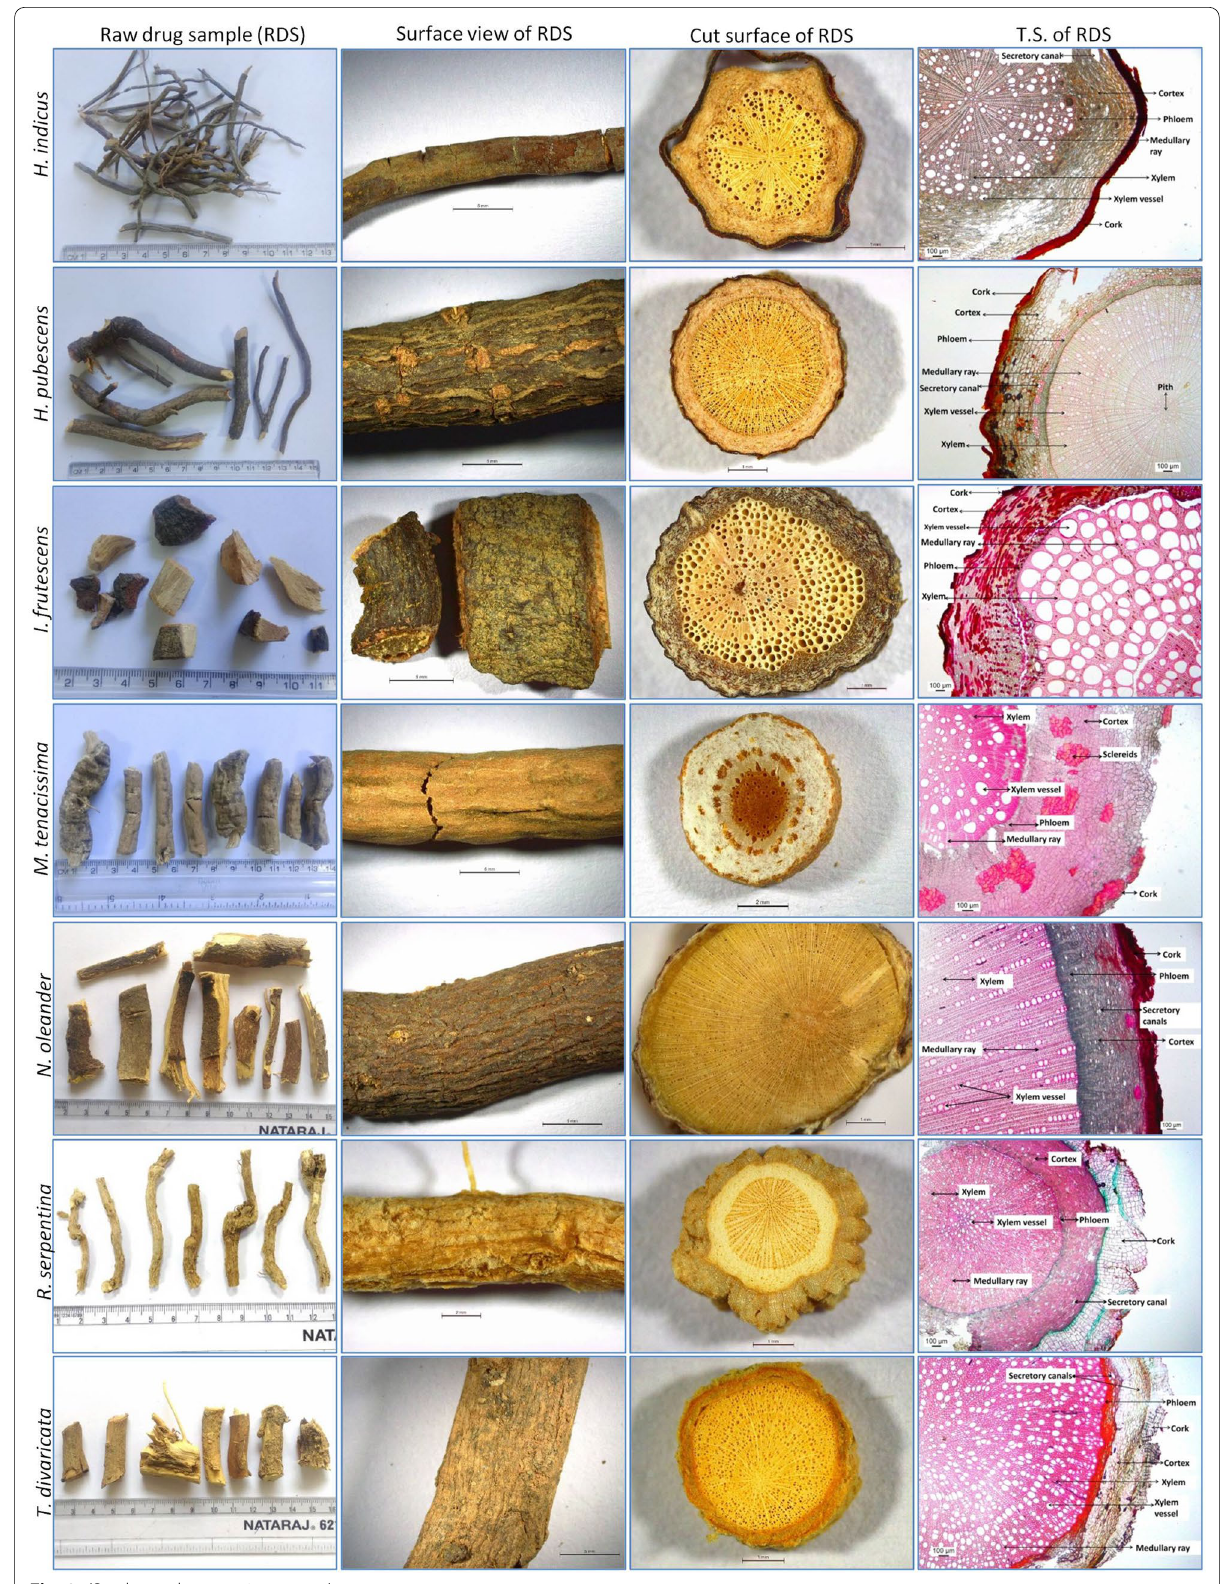
Fig. 2 (See legend on previous